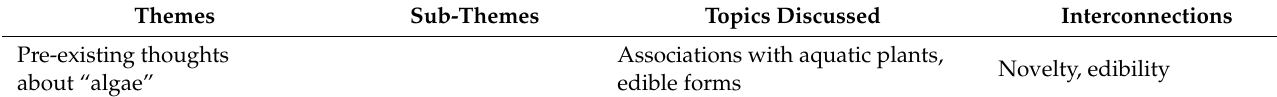
Table 2. Themes, subthemes, and interconnections between topics discussed in focus